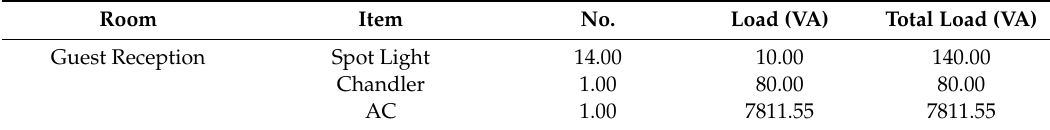
Table A1. List of the loads for the ground floor in each